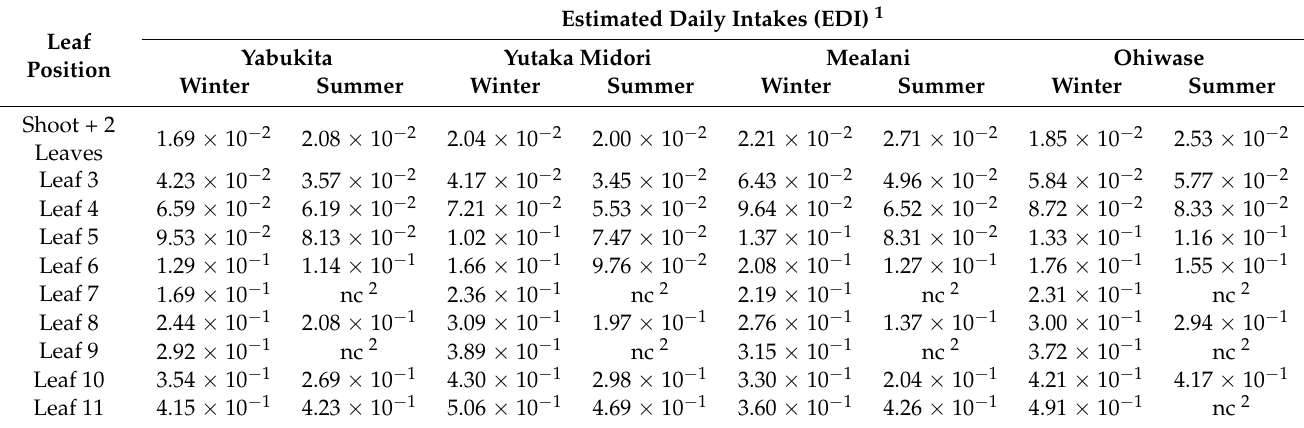
Table 2. Estimated daily intakes (EDI) ( µ g/g body weight/day) of Al for consumers due to tea